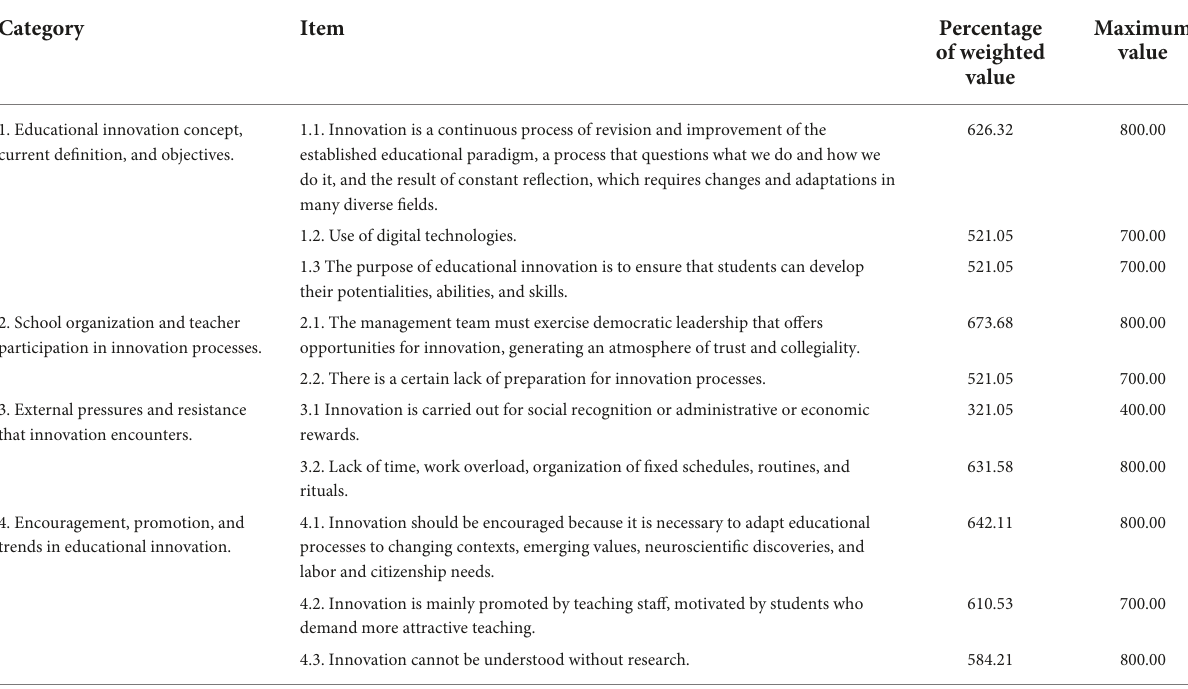
TABLE 4 Items rated with the highest priority for each question on educational innovation and innovation culture. Category